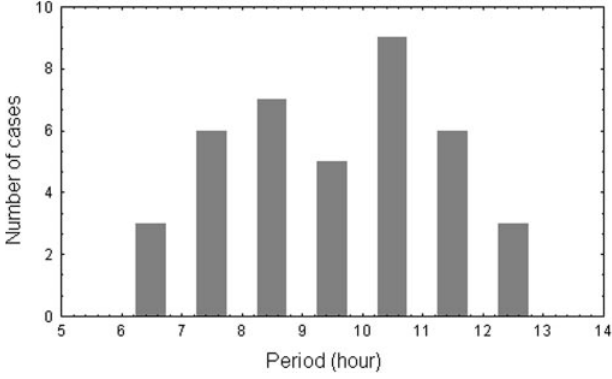
Fig. 5. A histogram of intradiurnal wave periods observed from January 19, 1995 to January